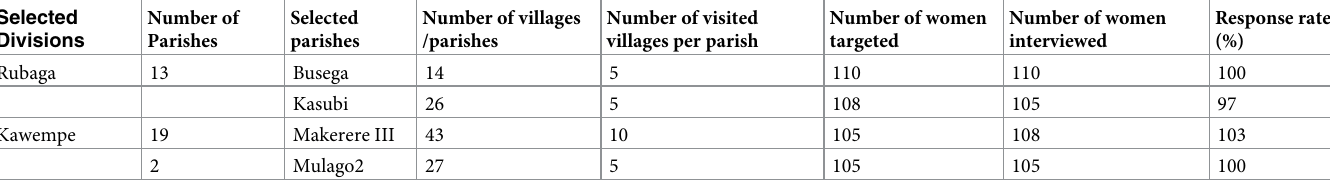
Table 1. Selection of the